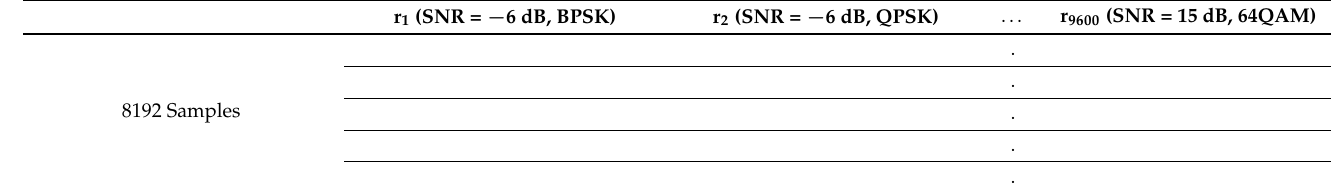
Table 1. Data-set generation over different SNR values. A number of 9600 received signals. Note that for each pair of combination we generate 200 signals.